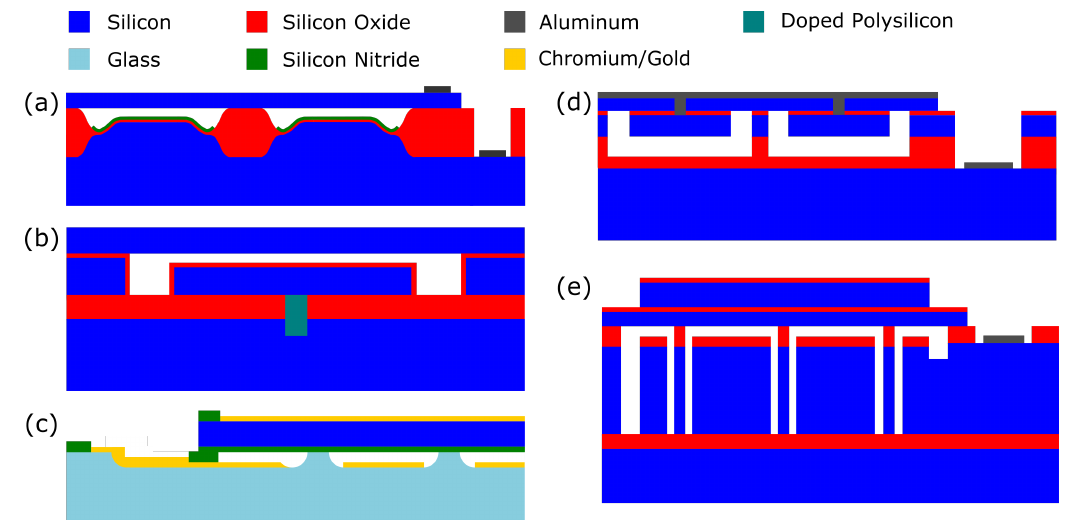
Figure 9. ( a – c ) Wafer-bonded CMUT structures. ( a ) Local oxidation of silicon (LOCOS) wafer-bonded CMUT. ( b ) Thick buried oxide (BOX) CMUT. ( c ) Anodic-bonded CMUT. ( d – e ) Structures to improve average displacement shown for comparison. ( d ) Piston CMUT fabricated with a double wafer-bonding process. ( e ) Post